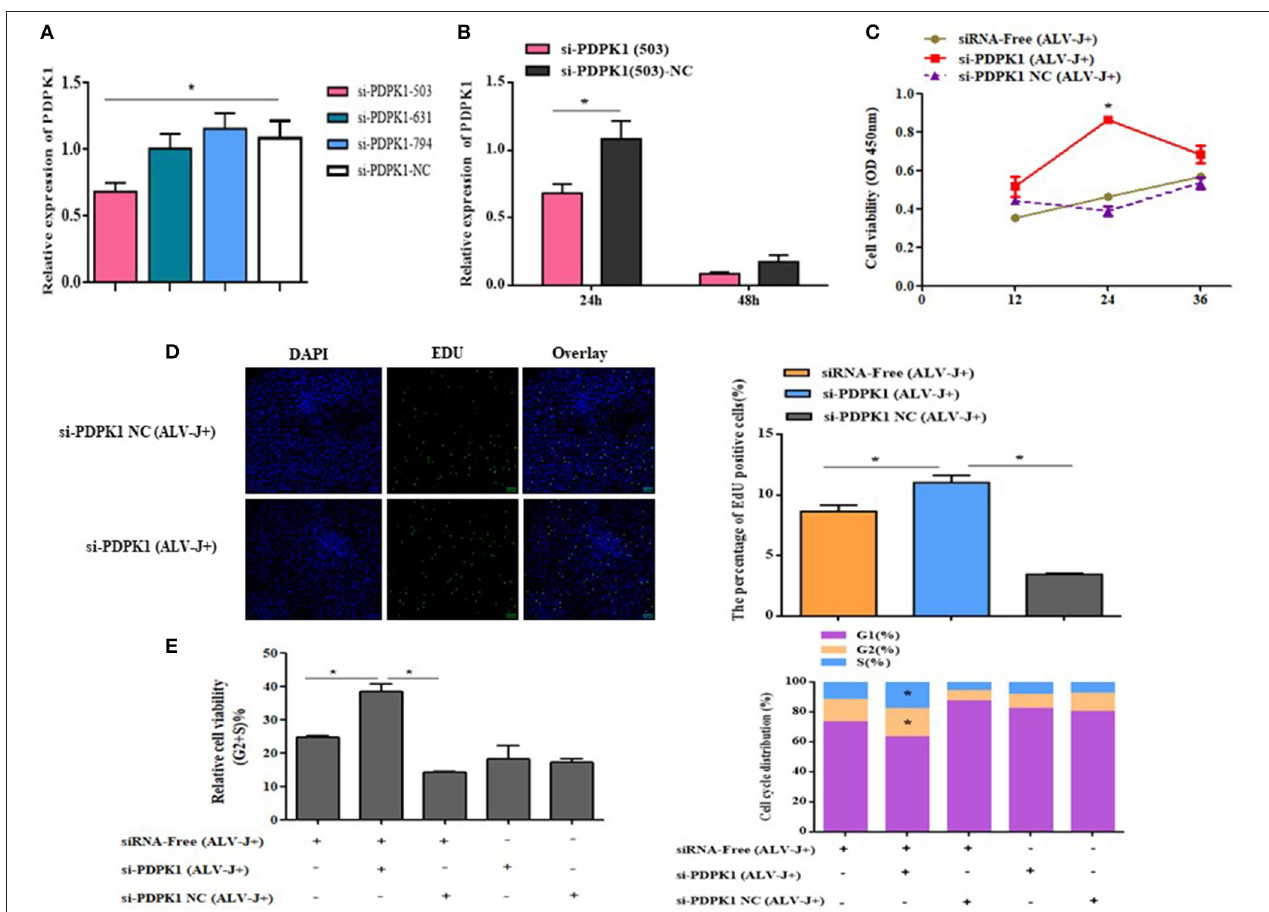
FIGURE 9 | The effect of knockdown of PDPK1 on the proliferation and cell cycle progression of ALV-J-infected CEF cell. (A,B) Screening PDPK1 interfering fragments and verifies the PDPK1 relative expression after transfected si- PDPK1 (503). (C) Cell growth curves measured by CCK-8 assays following transfection with si- PDPK1 and negative control in ALV-J-infected CEF cells. (D) The results of the EdU assay for CEF cells transfected with si- PDPK1 and negative control, where EdU (green) fluorescence is used as an indicator of proliferation, and nuclei are indicated by DAPI (blue) fluorescence, micrographs were taken using × 200 magnification. (E) Cell cycle was promoted with PDPK1 knockdown. All of the error bars represent the means ± SEM of triplicated experiments. * P < 0.05.